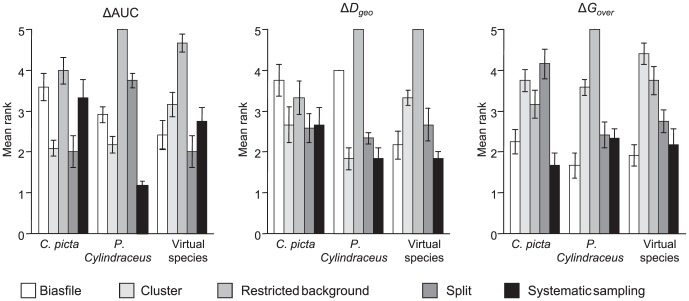
Rank of each method to correct sampling bias.Mean ranks ± standard-error for the performance of each method to correct sampling bias for each species (Chrysemys picta: left, Plethodon cylindraceus: center, virtual species: right), following 3 measures of correction performance: ΔAUC (left), ΔDgeo (centre), and ΔGover (right). For each type of bias and bias intensity, the method which results in the most efficient correction is set to 1 whereas the least powerful method is set to 5. The plotted values are the mean rank across the 4 types of bias and 3 intensities.